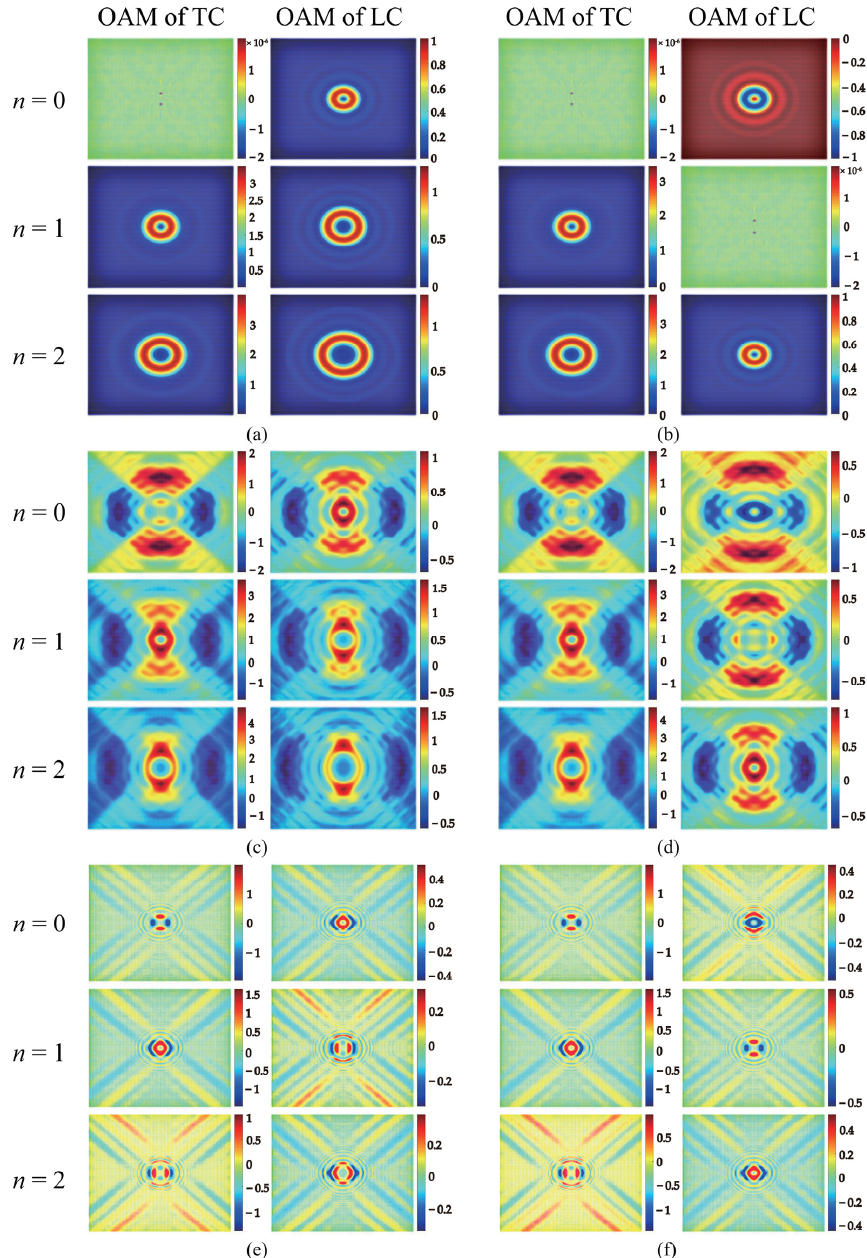
Figure 6. The OAM distribution of a focused scalar circularly polarized beam in the focal region with different vortex topological charges without ( a , b ) or with ( c , d ) the modulation of a twisting phase: ( a ) the left circularly polarized light (the initial field with m = 0 and φ 0 = π /4 in Equation (1)), ( b ) the right circularly polarized light (the initial field with m = 0 and φ 0 = − π /4 in Equation (1)), ( c ) the left circularly polarized light modulated by a twisting phase with u = 10 13 mm − 2 , ( d ) the right circularly polarized light modulated by a twisting phase with u = 10 13 mm − 2 , ( e ) the left circularly polarized light modulated by a twisting phase with u = 8 × 10 13 mm − 2 , ( f ) the right circularly polarized light modulated by a twisting phase with u = 8 × 10 13 mm − 2 . Here the size of each plot is 3 λ × 3 λ